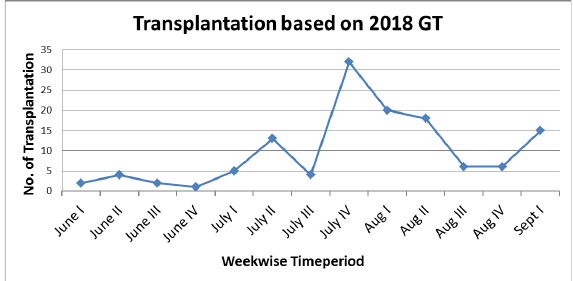
Figure 3: Transplantation plot for Andhra Pradesh based on GT points